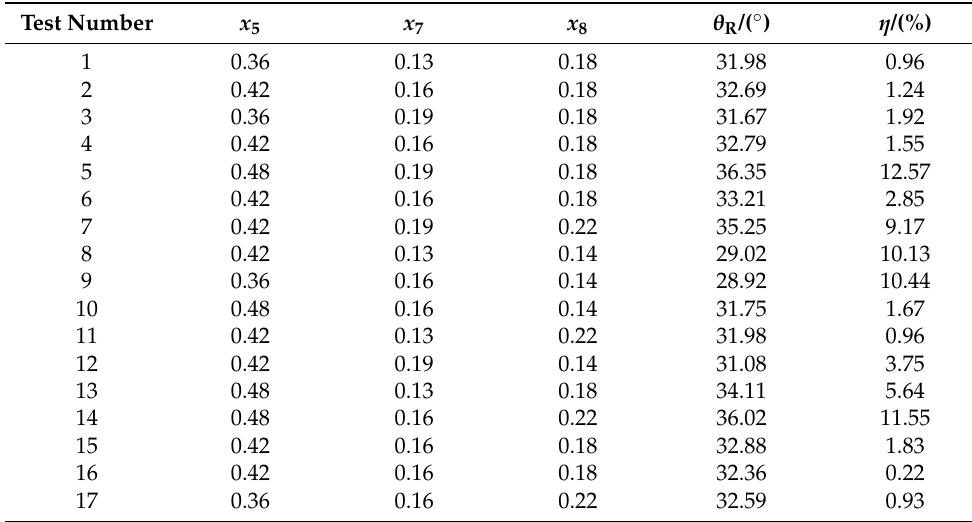
Table 7. Design matrix and results of the BBD test for the θ R .